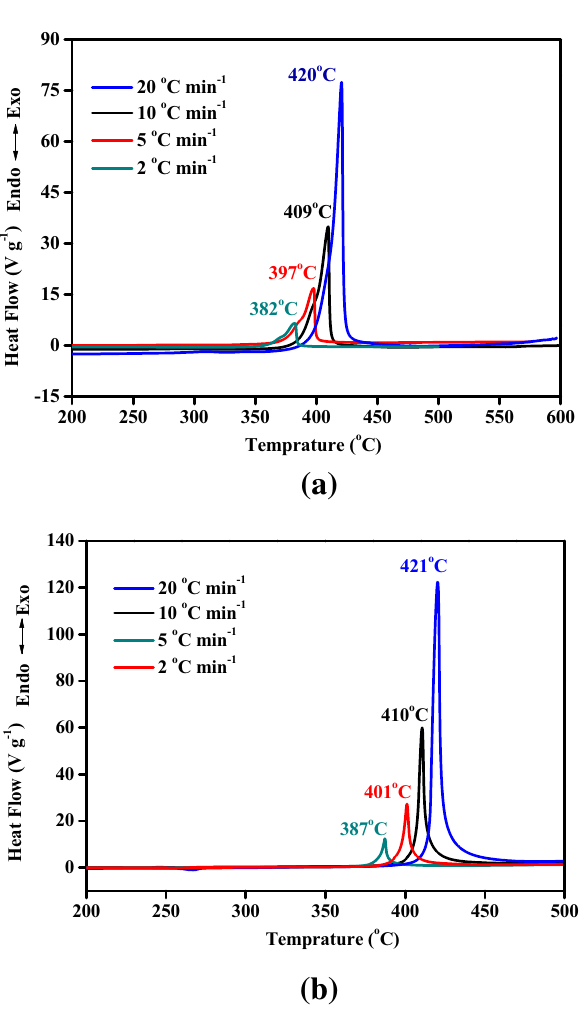
Figure 7. DSC measurements of y-PTACOT ( a ) and z-TACOT ( b ) at the heating rates of 2, 5, 10 and 20 °C min −1